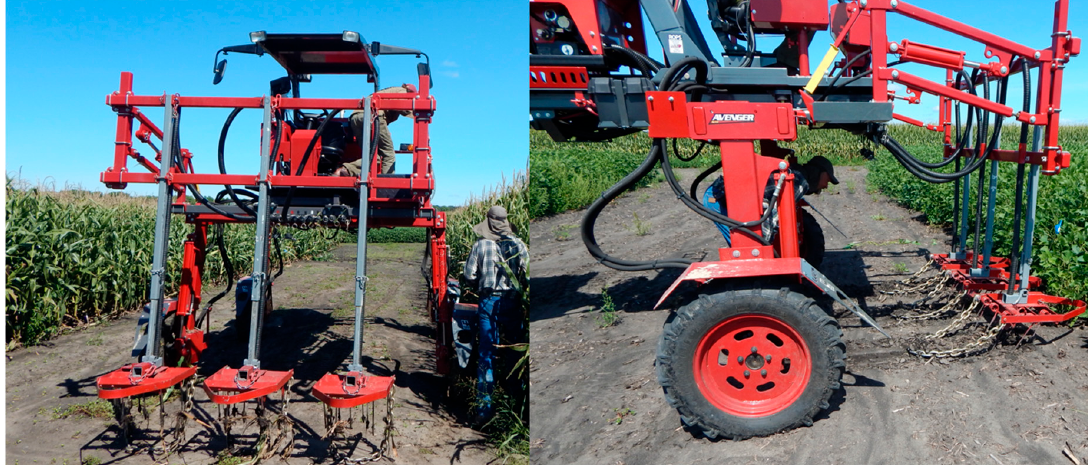
Figure 1. Modified Avenger high-clearance tractor outfitted with a Gandy Co. Orbit Air Seeder. Drop